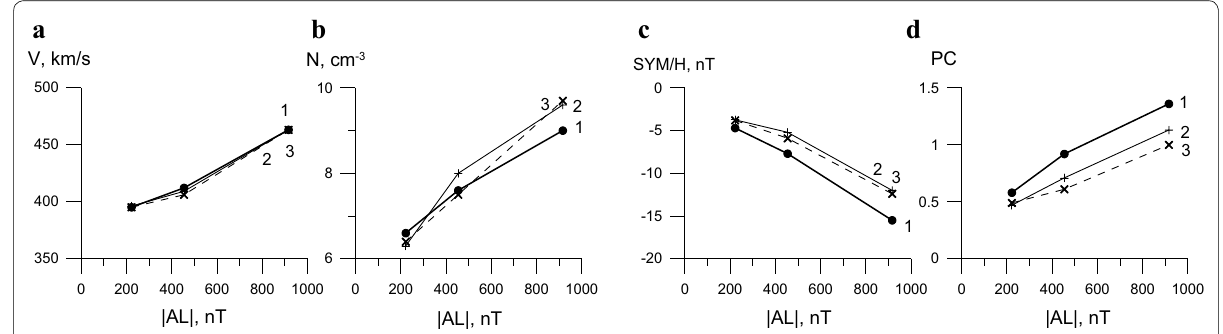
Fig. 1 Average values of the solar wind velocity ( a ) and number density ( b ); SYM/H ( c ) and PC ( d ) indices of geomagnetic activity versus substorm intensity. The averaging is performed over 1-h interval starting one (curve 1), two (curve 2), and three (curve 3) hours before substorm onset